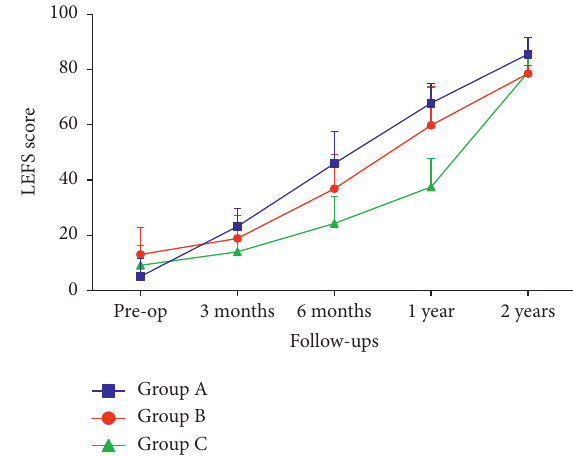
Figure 3: Graphical representation showing LEFS score at sub- sequent follow-up of patients of different